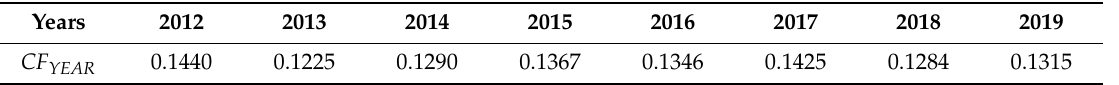
Table 2. The FTS PV power plant capacity factor.